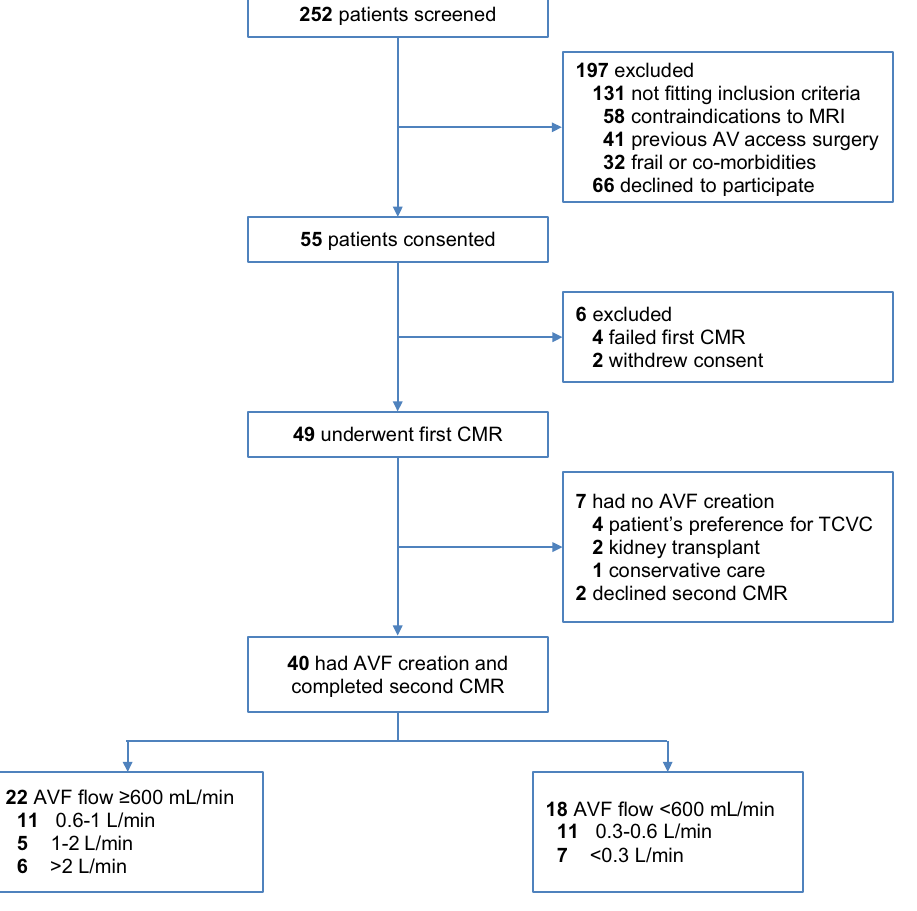
Figure 1. Flowchart showing recruitment and arteriovenous fistula (AVF)